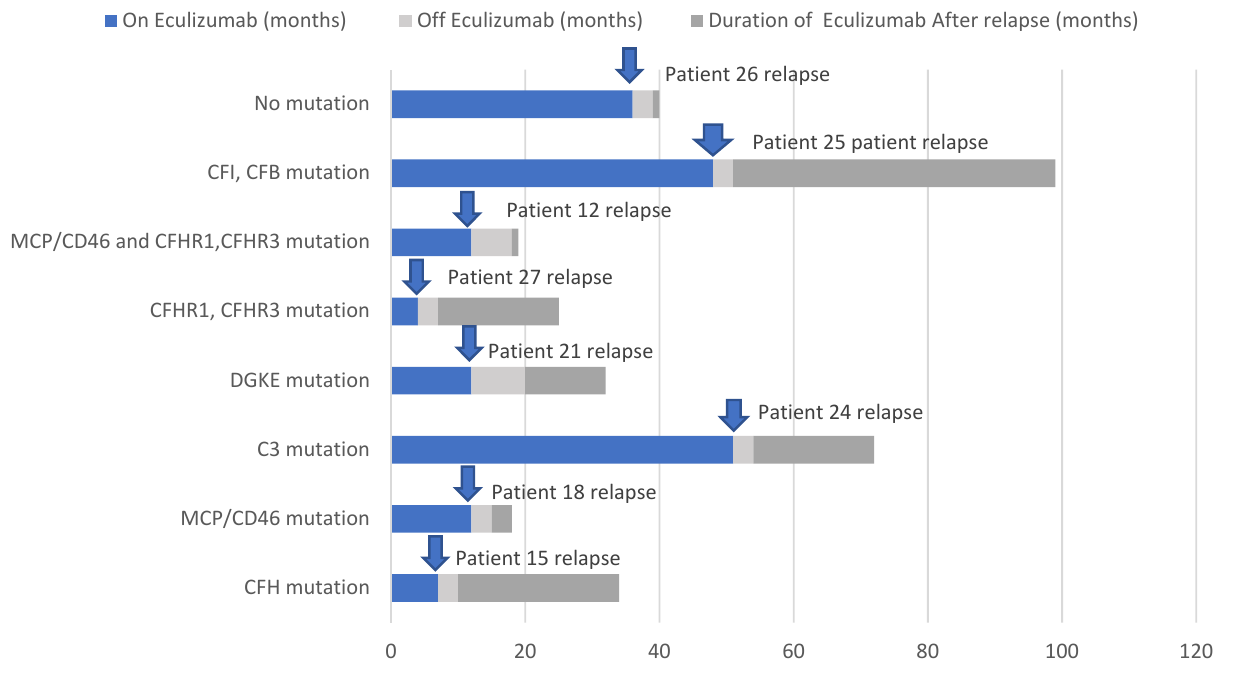
Figure 1. Durations of eculizumab (months) before and after relapse according to the type of gene mutation .